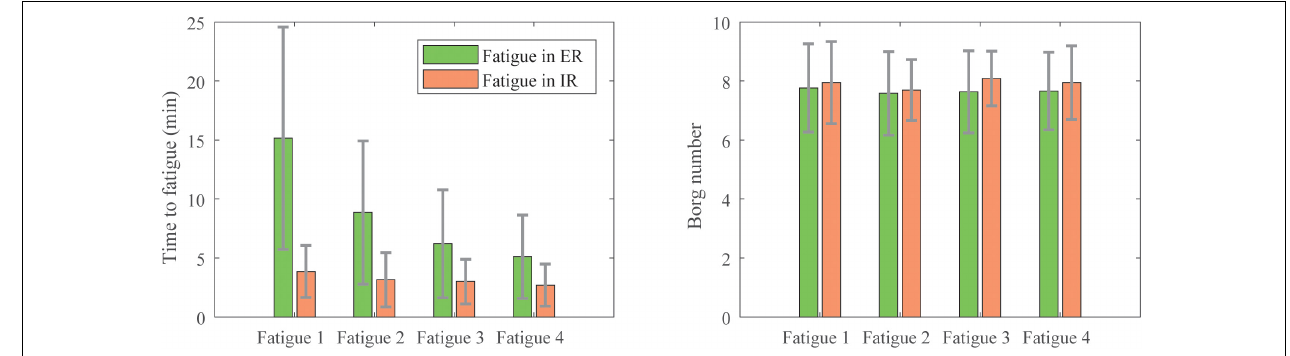
FIGURE 4 | Means and standard deviations of the duration of fatigue (Left) and the perceived exertion on the Borg scale (Right) of the participants during each of the four fatigue sessions. TABLE 1 | Percentage of participants ( N = 20) with significant differences for each component of their tests.